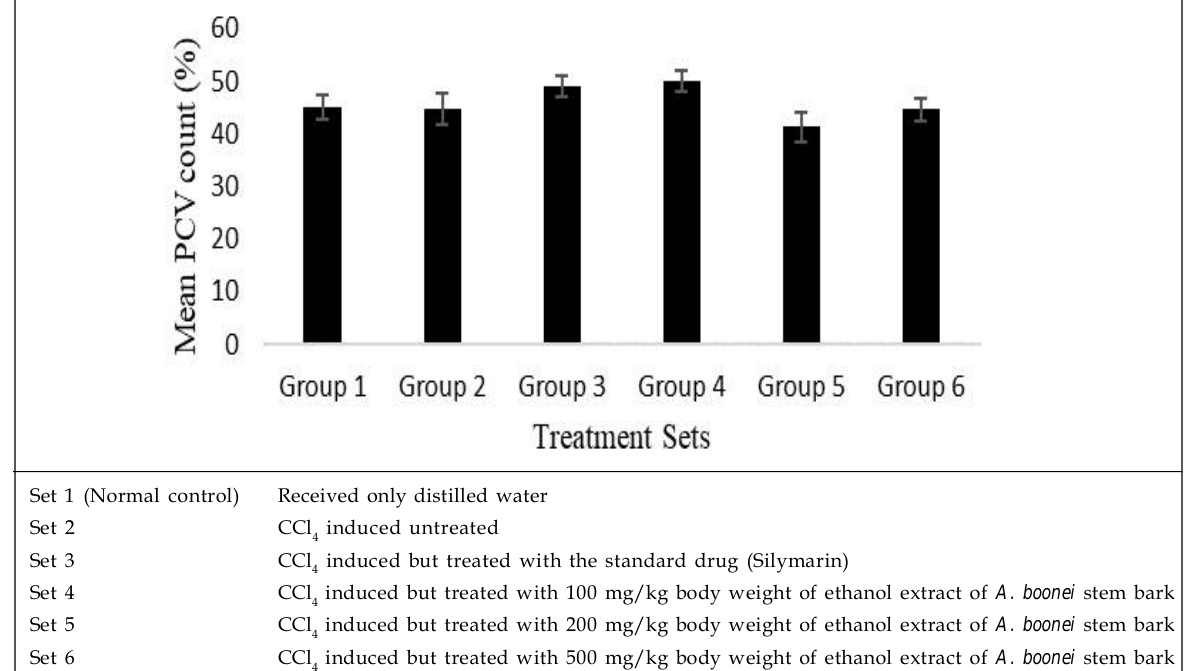
) induced male Wistar albino rats administered A. boonei 4